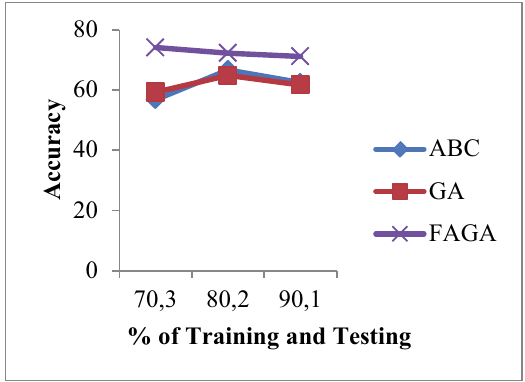
Fig.9. Accuracy using Heart Disease